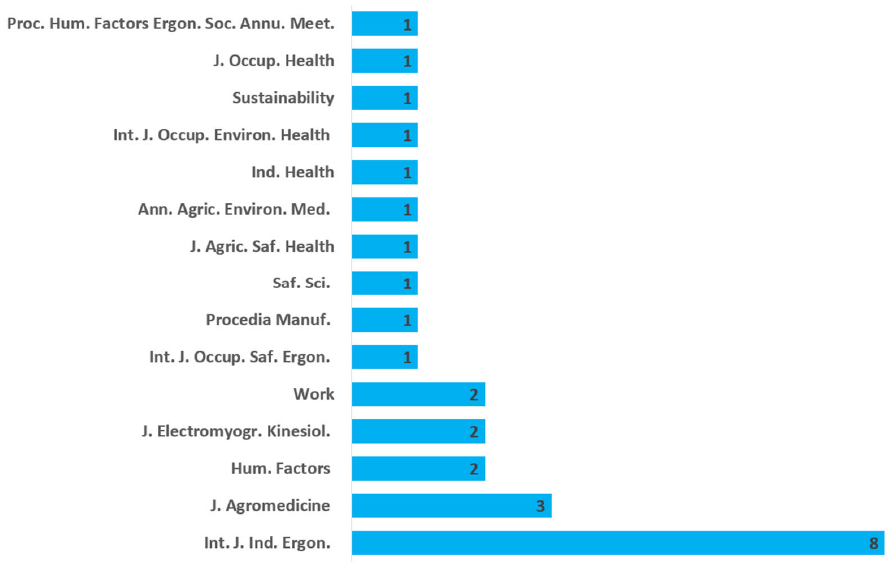
Figure 3. The distribution of all contributing international journals.